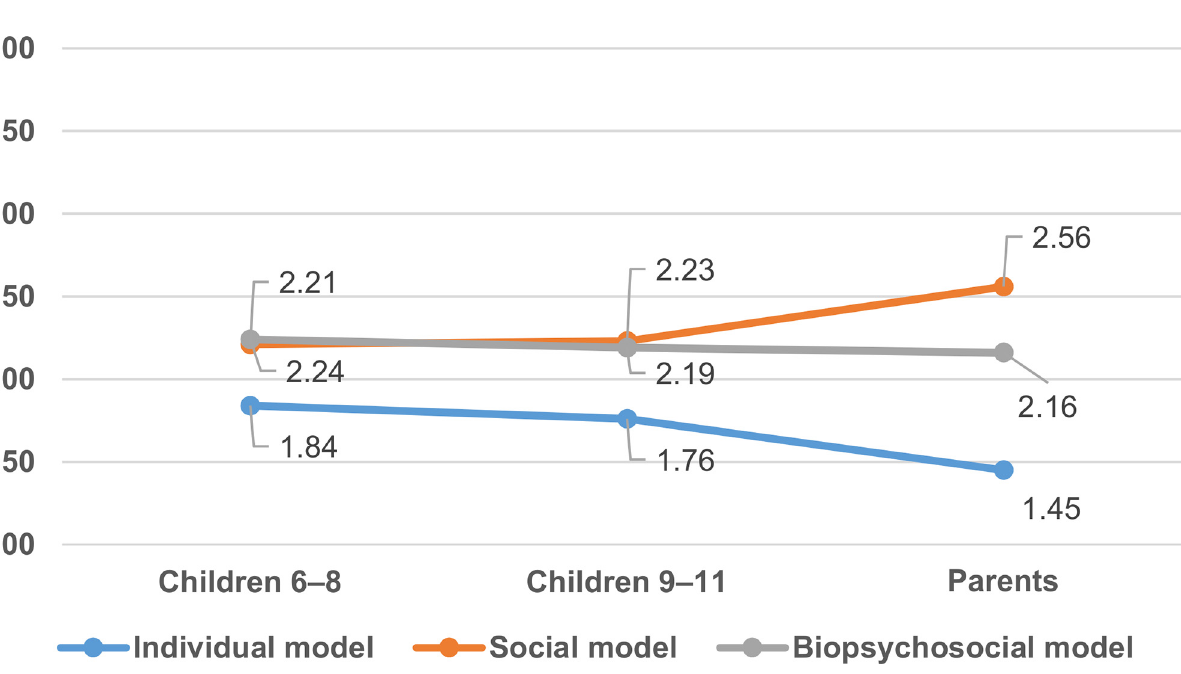
PLOS ONE | DOI:10.1371/journal.pone.0128876 June 8,